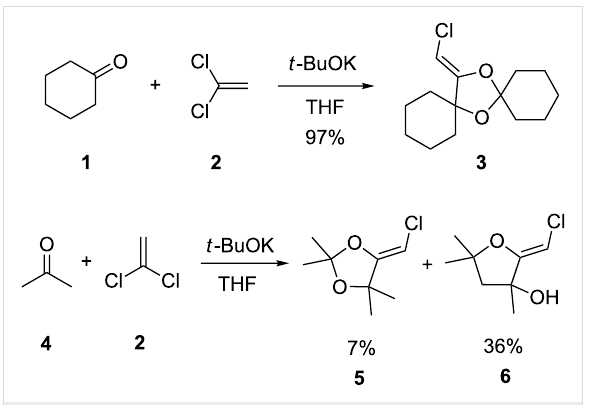
Scheme 1: Formation of ( Z )-chloro- exo